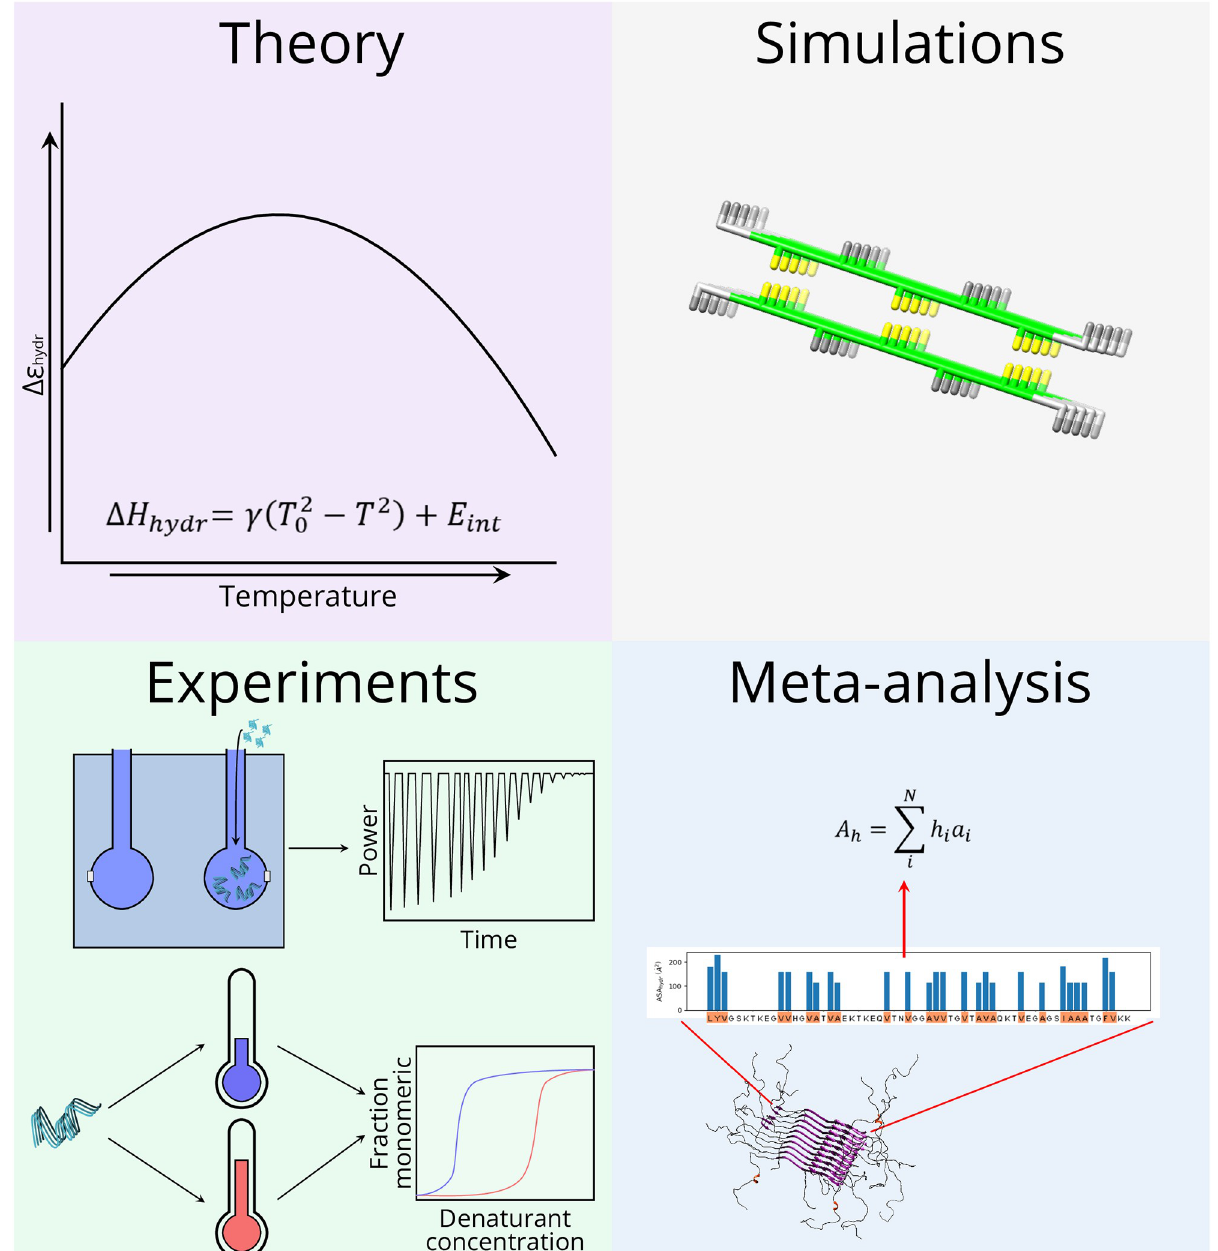
Fig 2. Main techniques used in this work. This work contains four main components: (I) Theory developed from previously published results, (II) A lattice model of fibril elongation, (III) Experimental measurements of the free energy and enthalpy of amyloid fibril elongation and the enthalpy of short peptide assembly, (IV) Meta-data analysis of the enthalpy of fibril elongation.